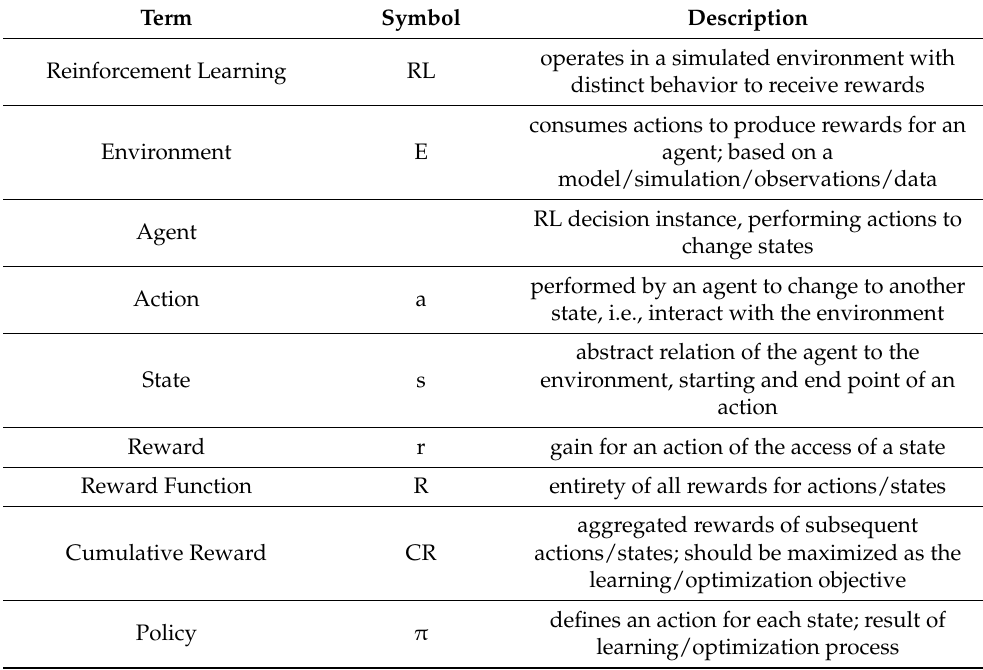
Table 1. Terminology of reinforcement